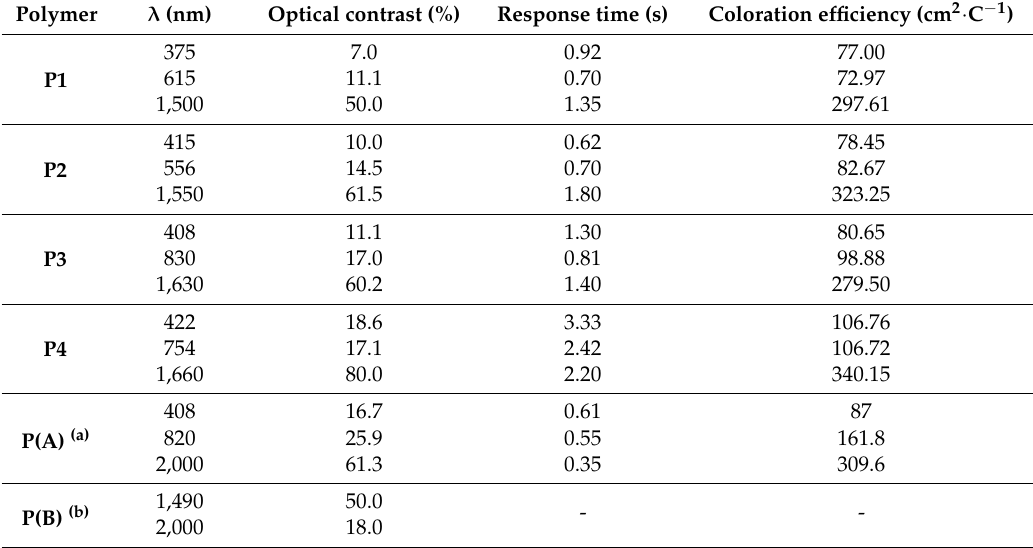
Table 4. The switching properties of the polymers.